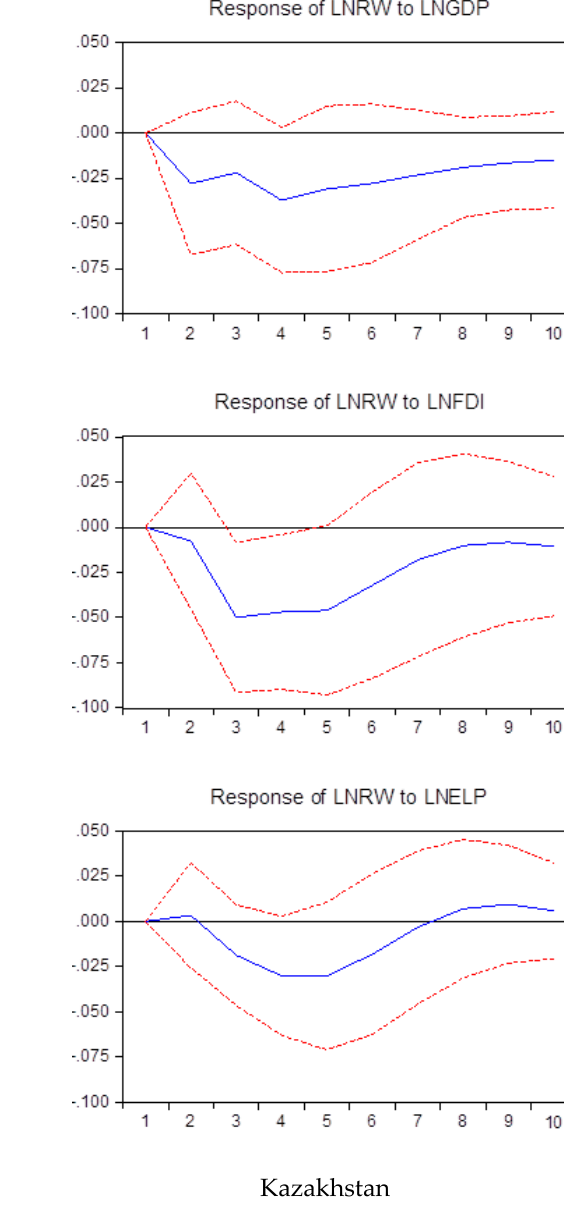
Figure 4. Impulse response function graphs. Table 7. Results of variance decomposition analysis